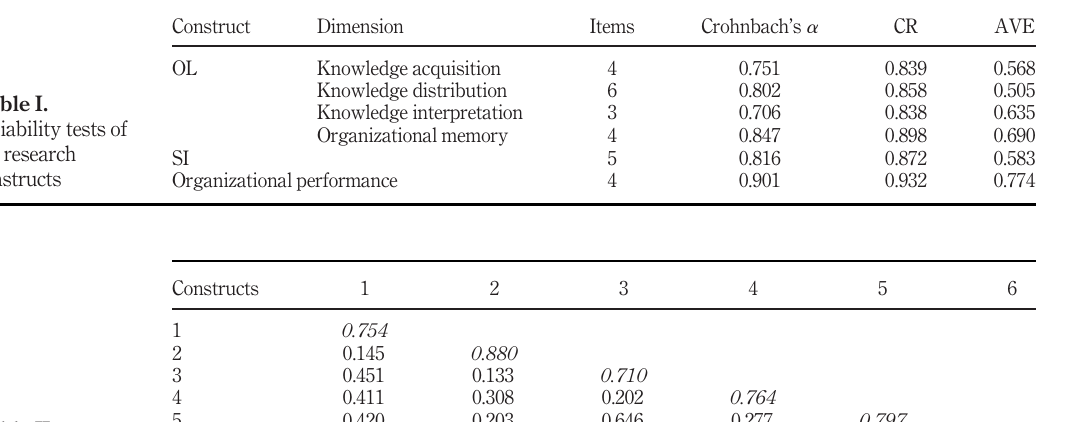
Table II. Fornell and Larcker (1981)